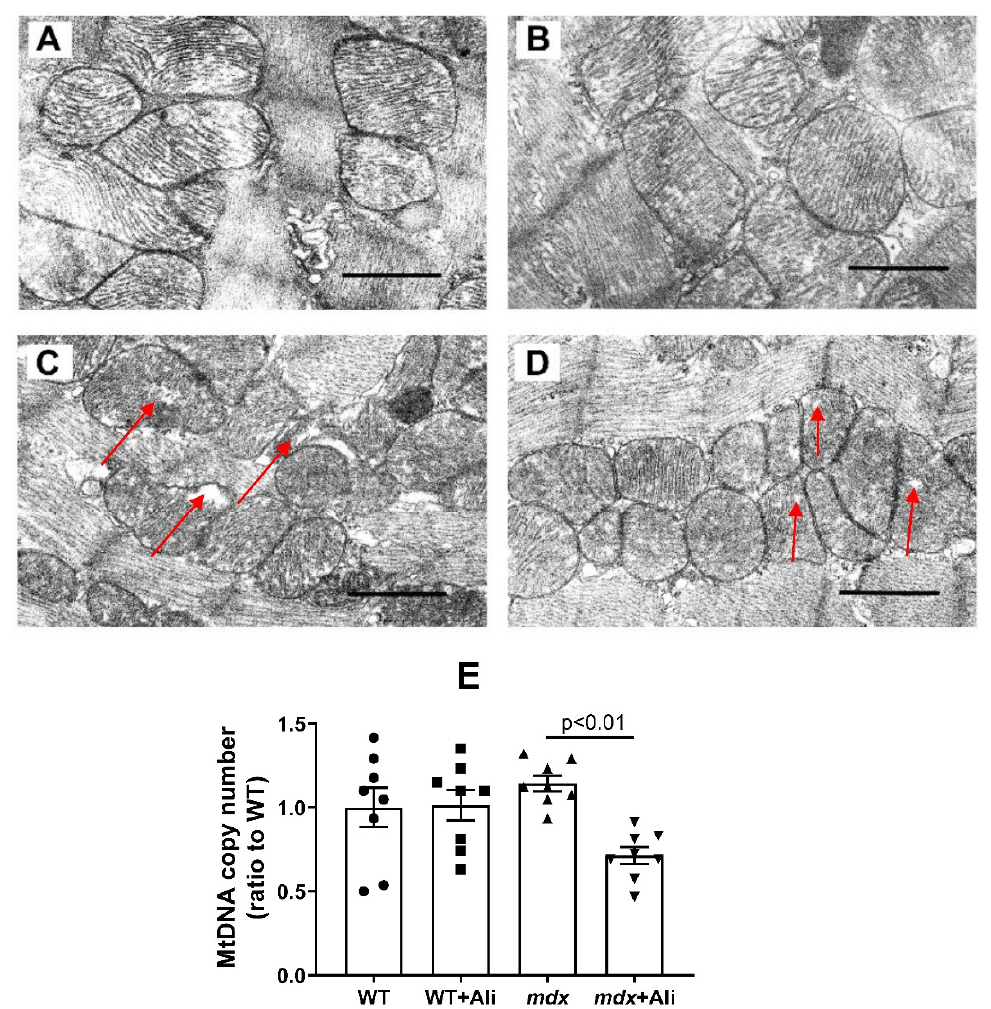
Figure 1. Typical electron micrographs of left ventricular mitochondria in the experimental groups: WT ( A ), WT + Ali ( B ), mdx ( C ), and mdx + Ali ( D ). Samples from two hearts were analyzed in each experimental group. The bar is equal to 1 μ m. Red arrows indicate individual abnormal mitochondria. MtDNA copy numbers ( E ). Data are presented as means ± SEM ( n = 6).